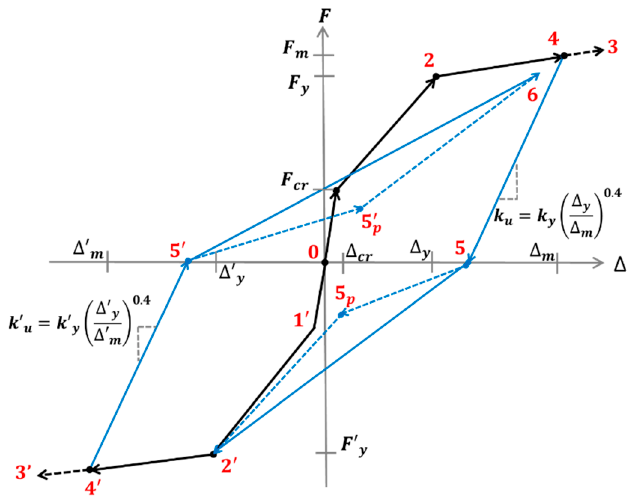
Figure A2. Trilinear hysteresis model [23,24]. The dotted blue line represents the option to include pinching.